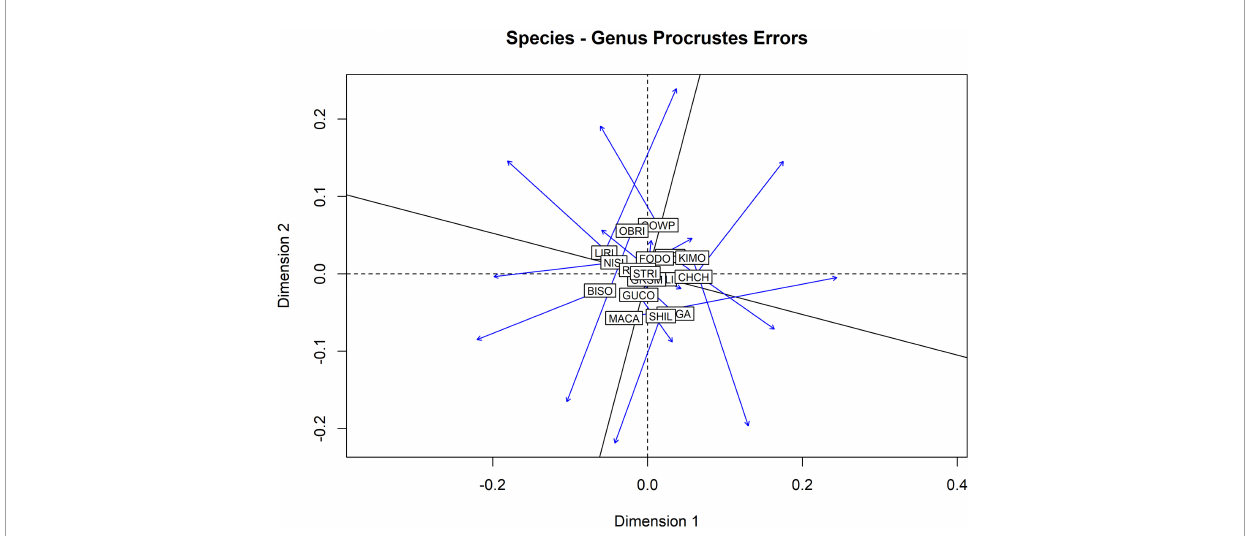
FIGURE6 Procrustes analysis of non-metric multidimensional scaling (NMDS) ordinations on pairwise jaccard distances of the aquatic insect assemblages observed in17 national parks. Stress scores for NMDS ordinations were high (0.28 species, 0.278 genus) and low (0.267) statistically insignificant (0.588) correlation was observed between the two